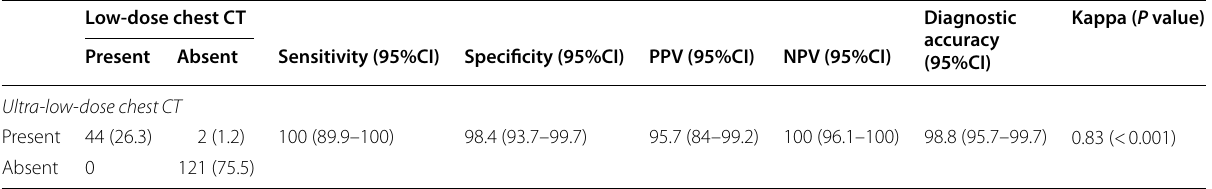
NPV negative predictive value, PPV positive predictive value, CI confidence interval